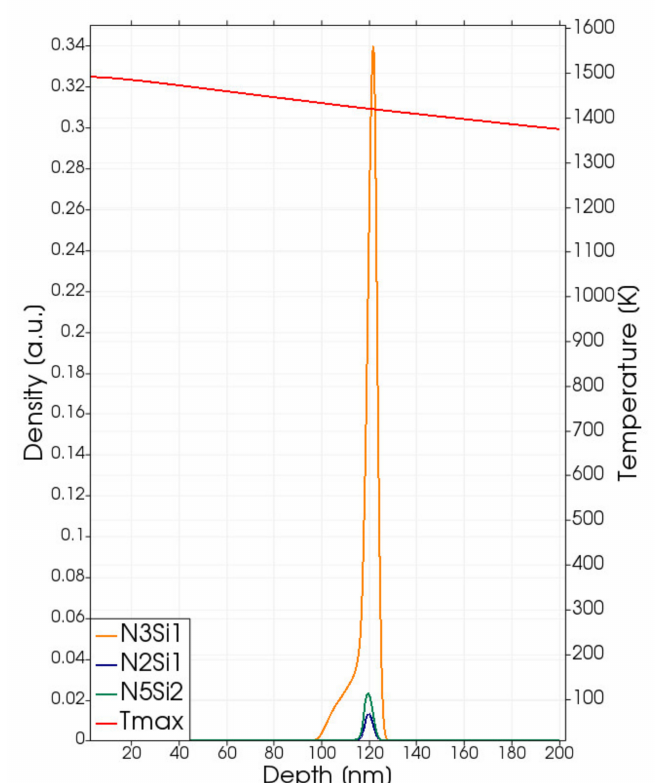
Figure 3. Simulated local density (left axis scale) at the end of the process of the Ni 3 Si (dark yellow lines), Ni 5 Si 2 class (dark green lines) and Ni 2 Si (blue lines) for Laser Annealing processes with fluences E dens = 2.2 J/cm 2 . Simulated local maximum temperature T max ( x ) (right axis scale), achieved in the different positions of the irradiated